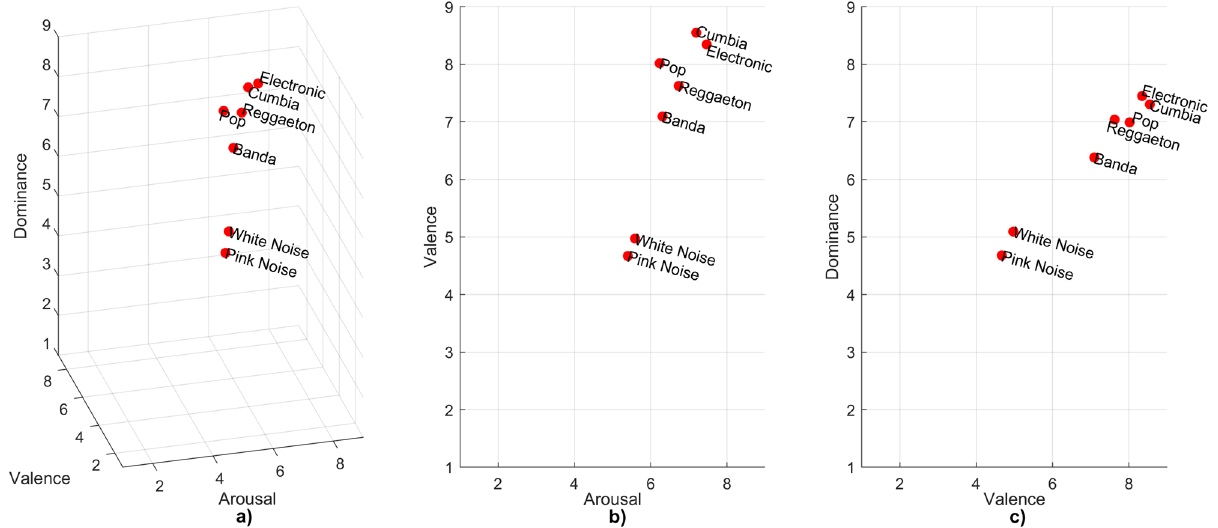
Figure 5. Distribution of mean ratings in the VAD model for seven additional sounds. ( a ) Three-dimensional space. ( b ) Arousal-valence plane. ( c ) Valence-dominance plane. The mean rating of each sound was calculated with the following ratings of participants: (1) Pop = 107; (2) Banda = 107; (3) Electronic = 107; (4) Cumbia = 119; (5) Reggaeton = 104; (6) Pink noise = 106; and (7) White noise =